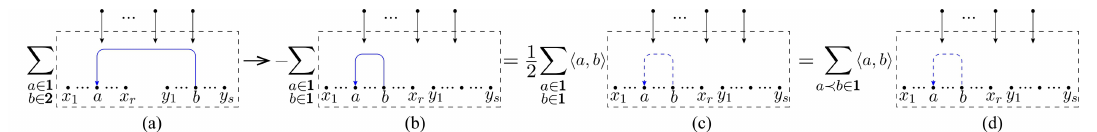
Figure 10 . The transformation of the boundary case that gluons a and b are directly connected via a type-1